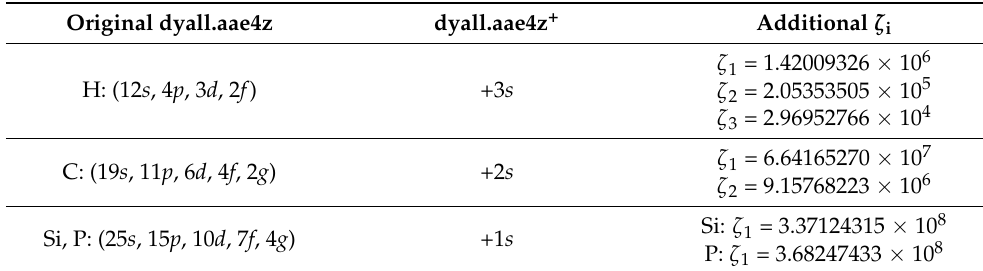
Table 1. Extension of the dyall.aae4z basis set to dyall.aae4z + . Original dyall.aae4z dyall.aae4z